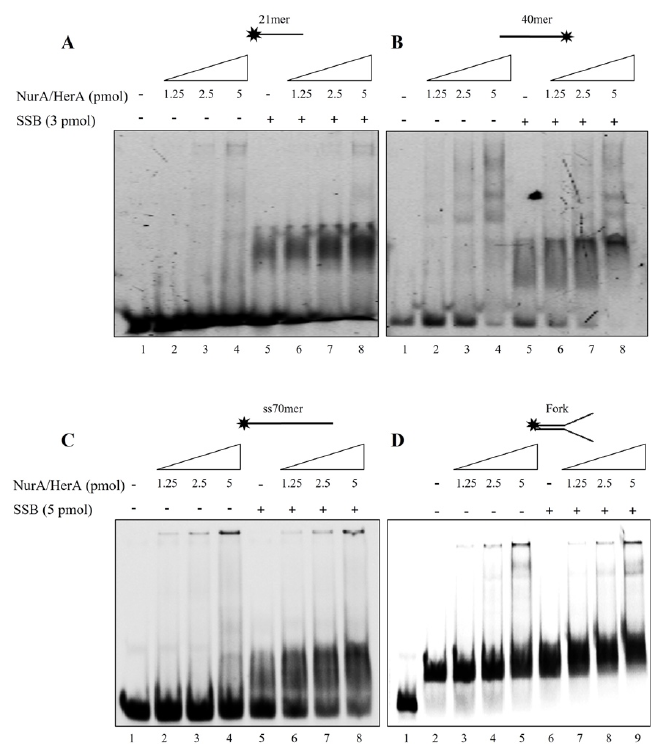
Figure 5. NurA/HerA and SSB mutual effect on different DNA substrates. ( A ) Increasing amounts of NurA/HerA complex were analyzed on a 21mer oligonucleotide in absence (lanes 2–4) and presence (lanes 6–8) of a fixed concentration of SSB (3 or 5 pmoles). Lane 5 refers to SSB binding to DNA, while lane 1 represents a negative control where no proteins were added in the reaction. The same assay conditions were performed using 40mer ( B ), 70mer ( C ) oligonucleotides and a forked DNA structure ( D ).